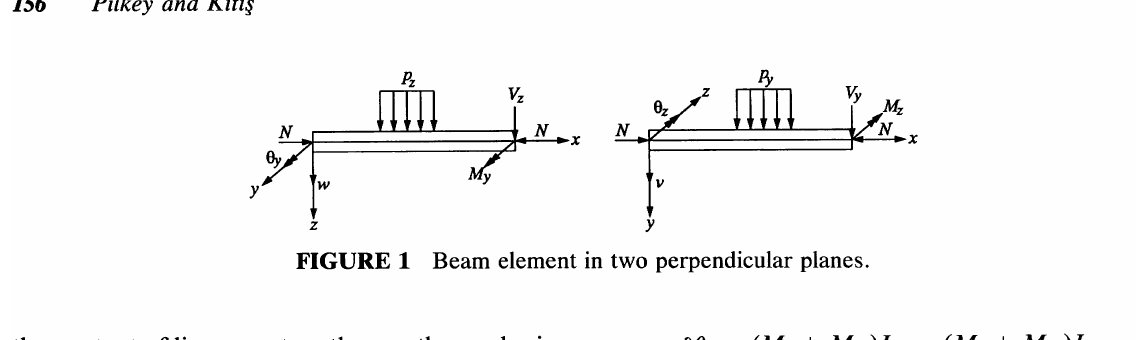
FIGURE 1 Beam element in two perpendicular planes.